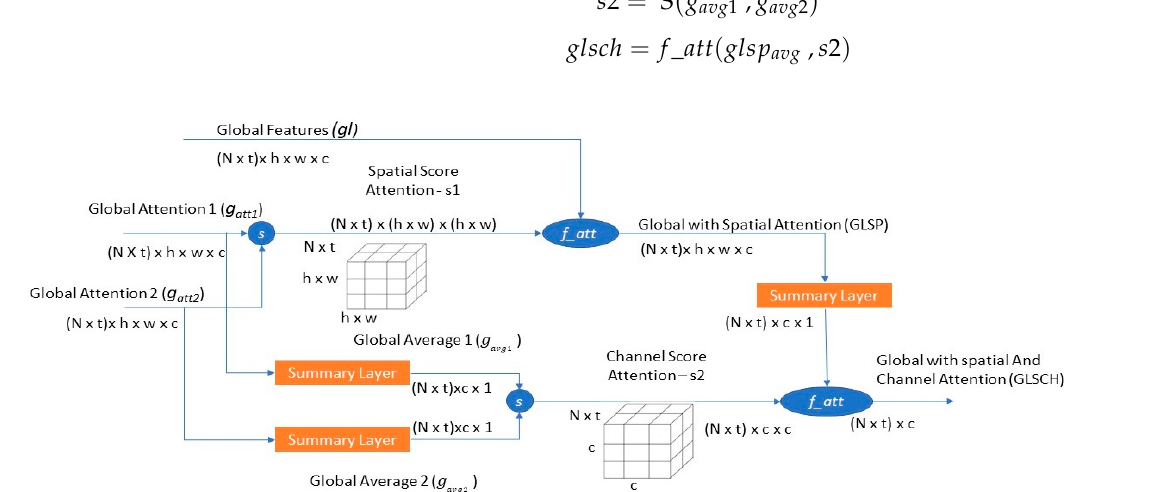
Figure 3. Self-Spatial with Channel Attention.